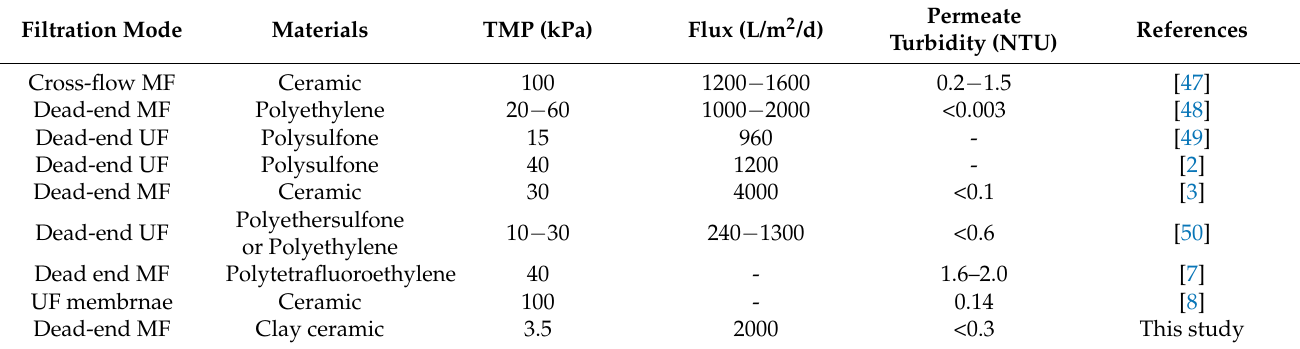
Table 6. Comparison of TMP, flux, and permeate turbidity of different BW treatment systems of previous studies and those of the current